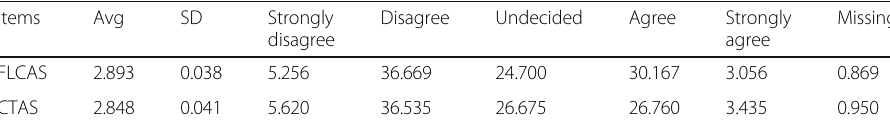
Table 2 FLCAS and CTAS average frequencies and descriptives Items Avg SD Strongly